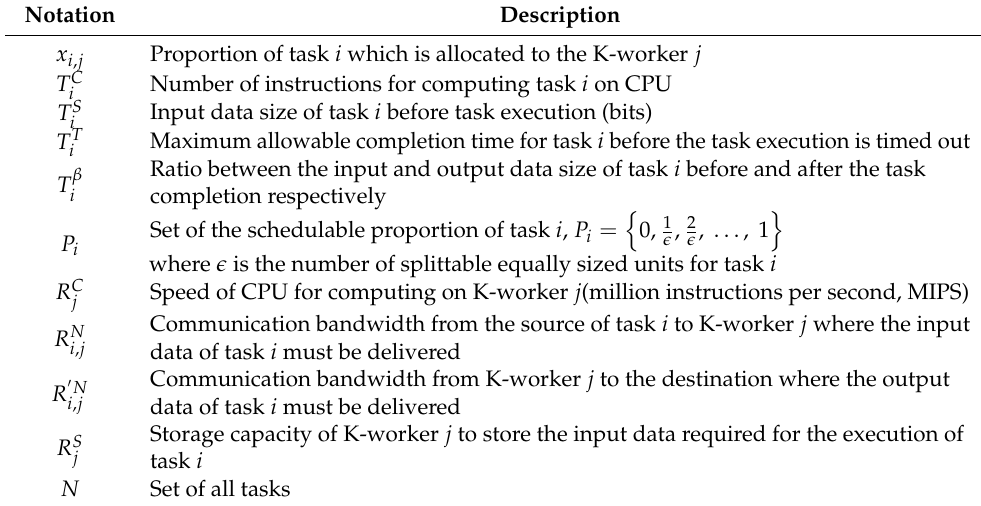
Table 1. Model Table 1. Model notations.